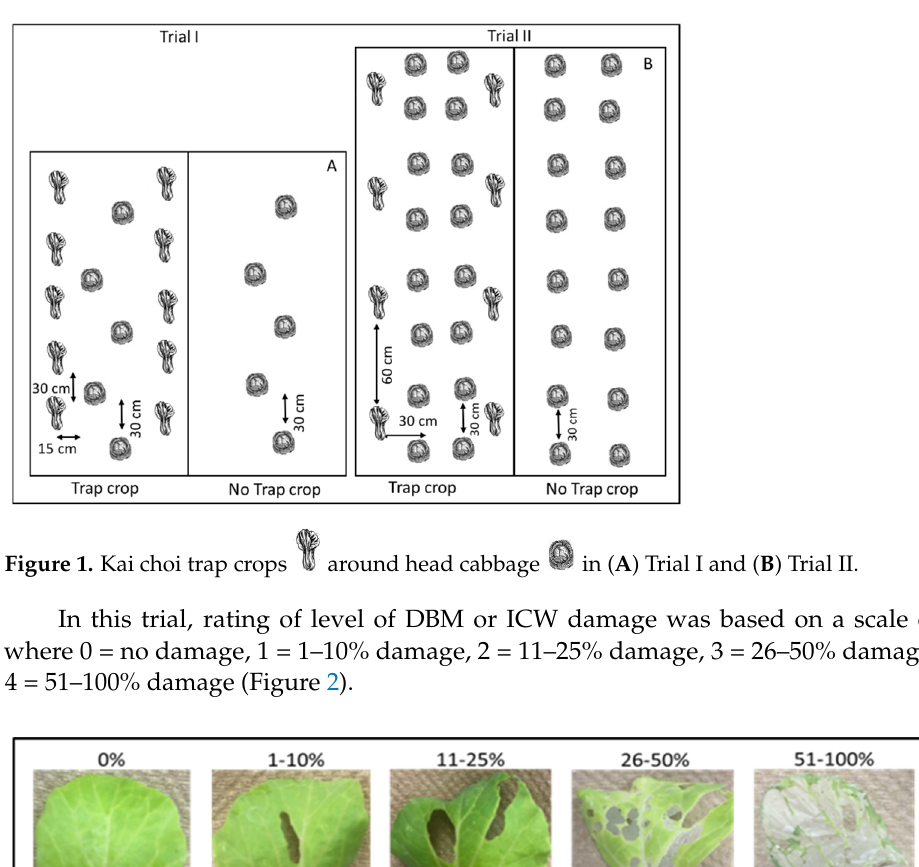
Figure 1. Kai choi trap crops around head cabbage in ( A ) Trial I and ( B ) Trial II.